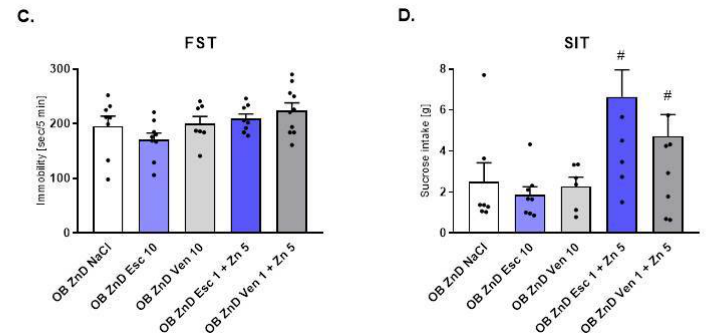
Figure 2. The effects of antidepressants (Esc (Escitalopram), Ven (Venlafaxine)) and Zn supplemen- tation on rats subjected to the OB + ZnD model in the OFT ( A , B ), FST ( C ), and SIT ( D ). Data were analyzed using a one-way ANOVA and the Newman–Keuls multiple comparisons test. # p < 0.05 vs. OB ZnD NaCl. Values are expressed as mean ± SEM ( n = 7–10).